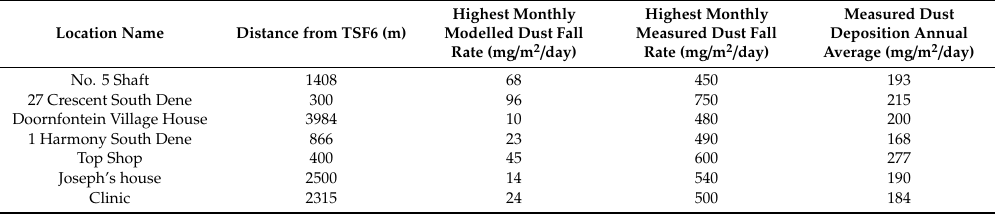
Table A2. Modelled and Measured dust fall, highest monthly dust deposition at all